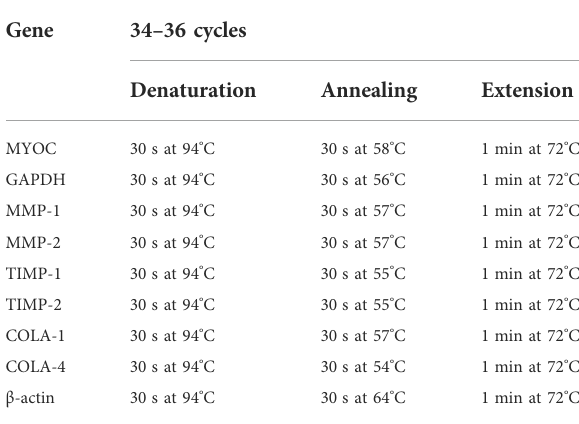
TABLE 1 Parameters used for RT-PCR.